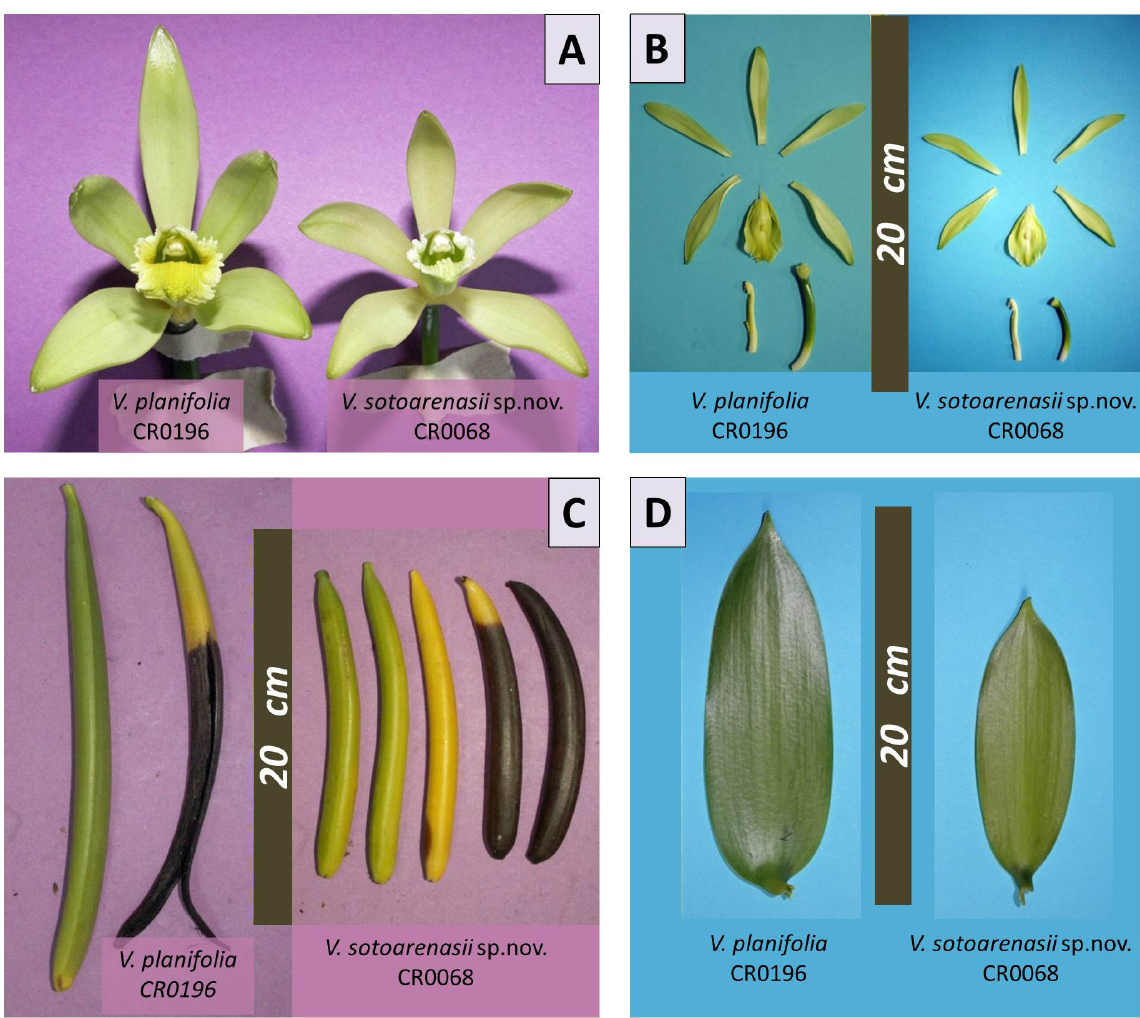
Fig. 3. Comparison of morphological traits between Vanilla sotoarenasii M.Pignal, Azofeifa-Bolaños & Grisoni sp. nov. (accession CR0068) and V. planifolia Jacks. ex Andrews (CR0196) cultivated under shade house in La Réunion. A . Front view of entire flowers. B . Separated flower parts. C . Mature fruits. D .